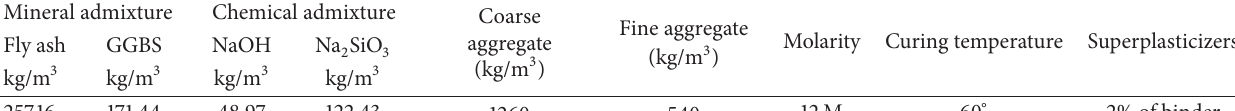
Table 4: Mix proportion for GPC.